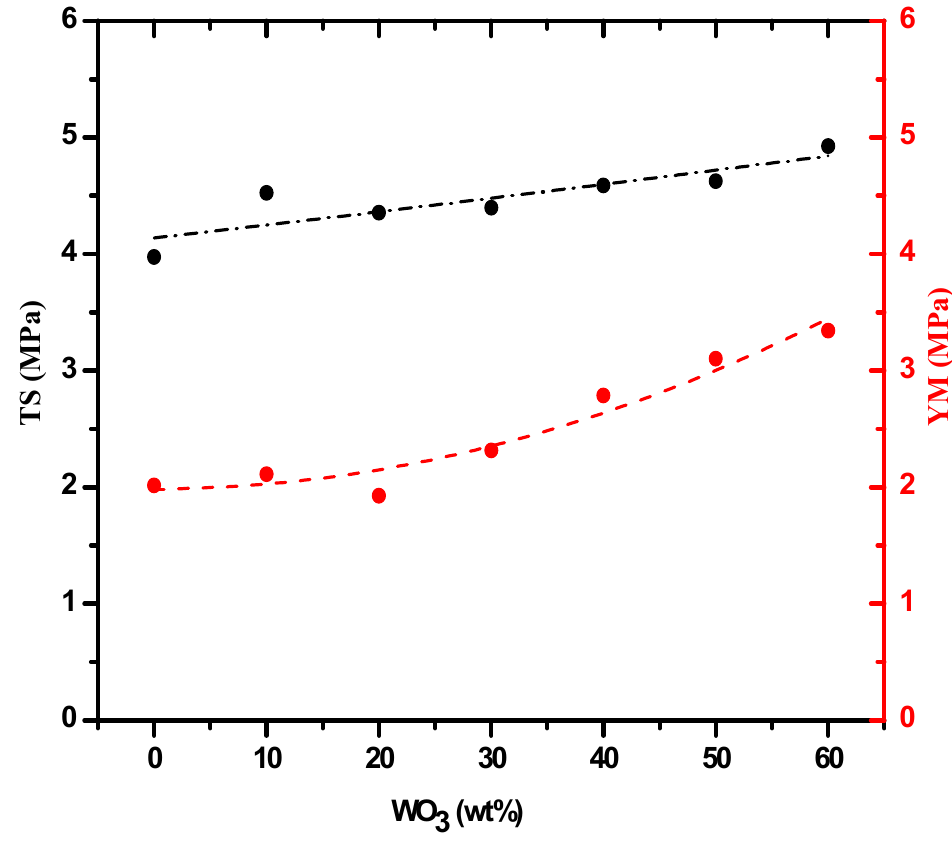
Figure 5. The tensile strength (TS) and young modulus of the SR-WO 3 systems.